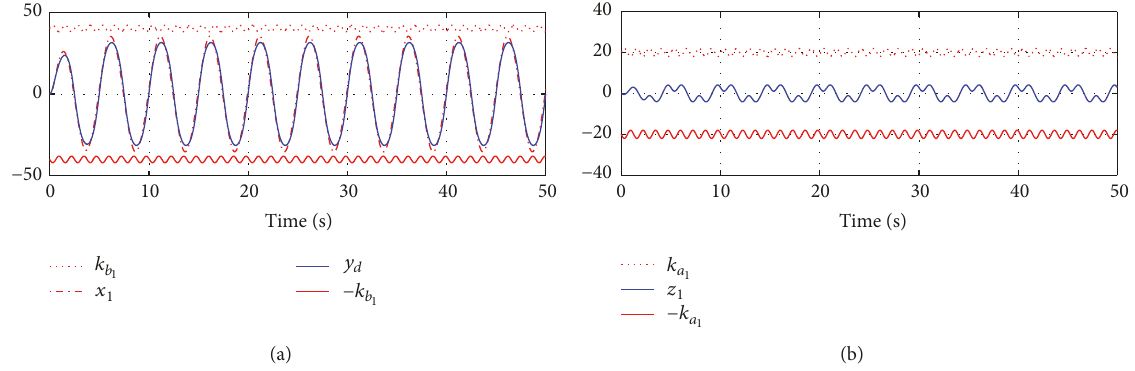
Figure 1: (a) Trajectories of 𝑥 1 (dashed) and 𝑦 𝑑 (solid); (b) the trajectory of tracking error 𝑧 1 .